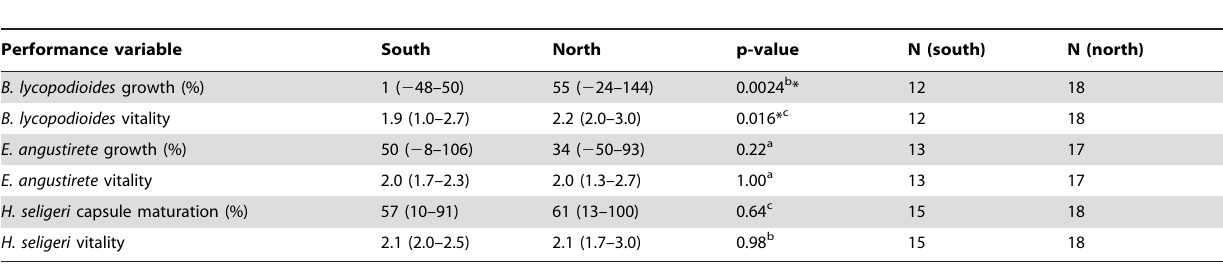
Table 2. Comparison of the transplant performance between south- and north-facing slopes.